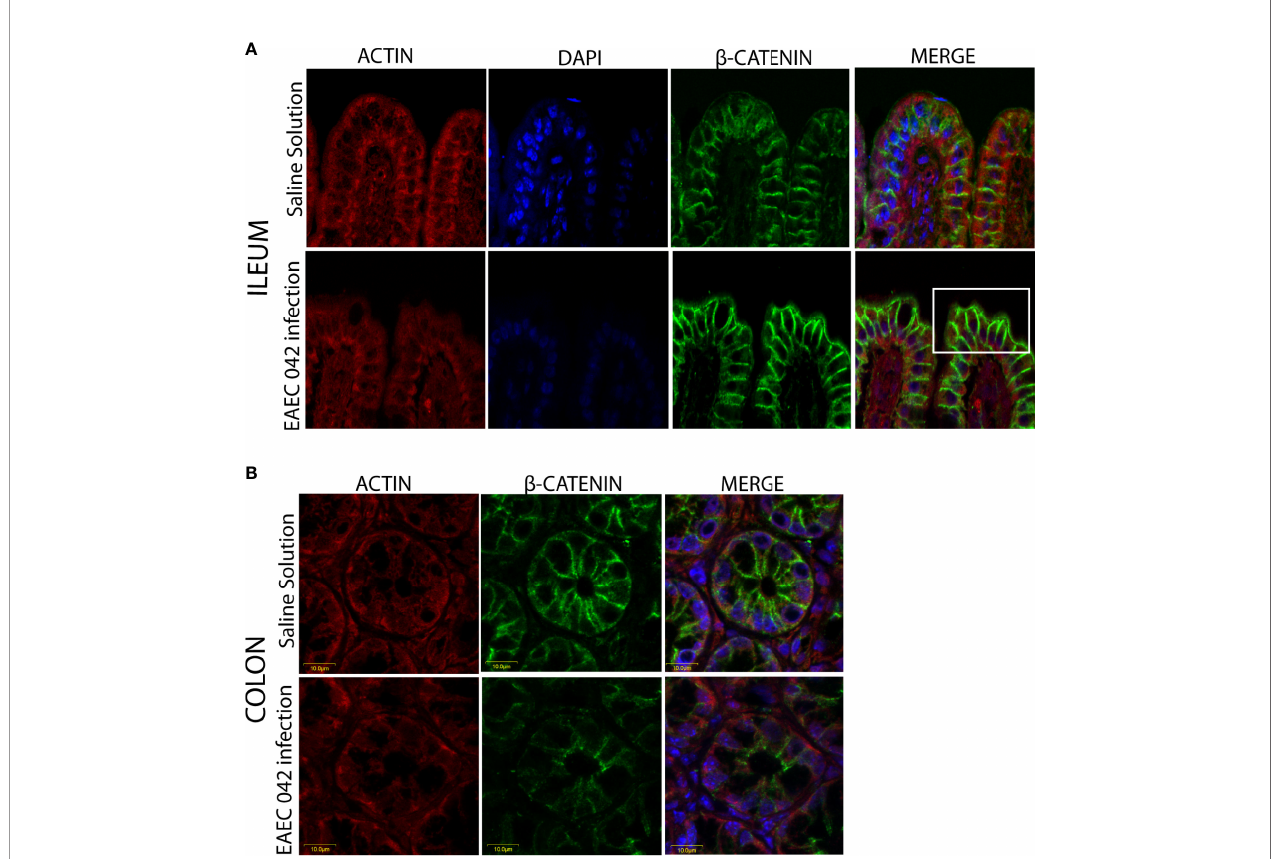
FIGURE 6 | Immuno fl uorescence of the adherent junction protein b -catenin at 7 days post-infection. (A) Ileum of mice with EAEC 042 infection and control mice with Saline Solution. (B) Colon of mice with EAEC 042 infection and control mice with Saline Solution. b -Catenin was stained with a secondary antibody conjugated